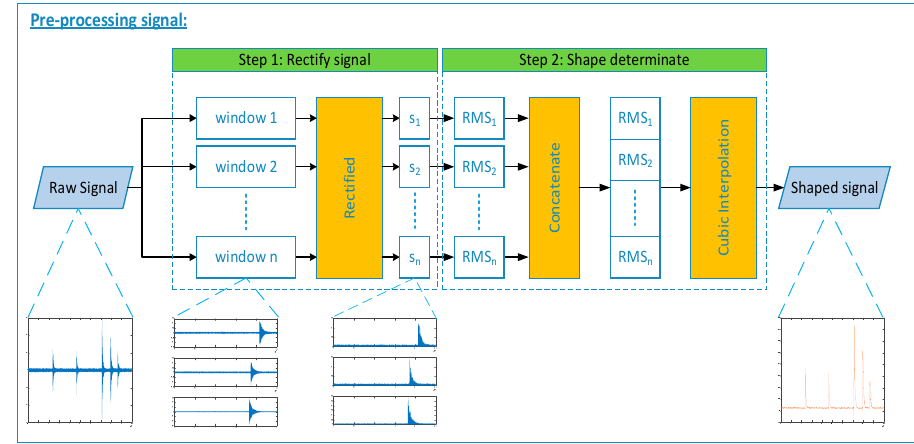
Figure 3. Preprocessing process of the acoustic emission (AE) signal.